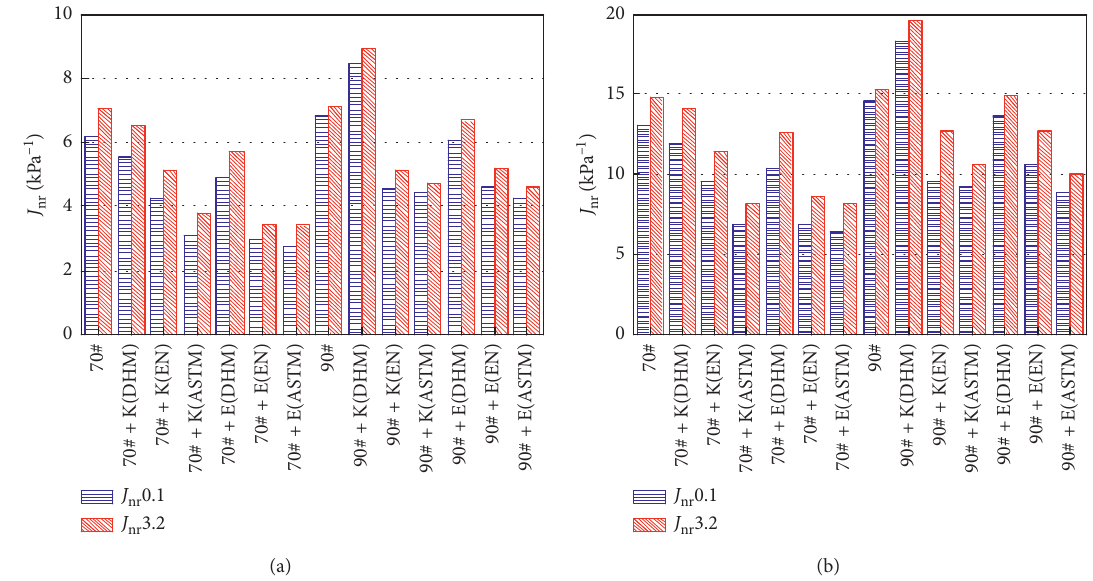
Figure 7: J nr values for emulsified asphalt residues at (a) 64